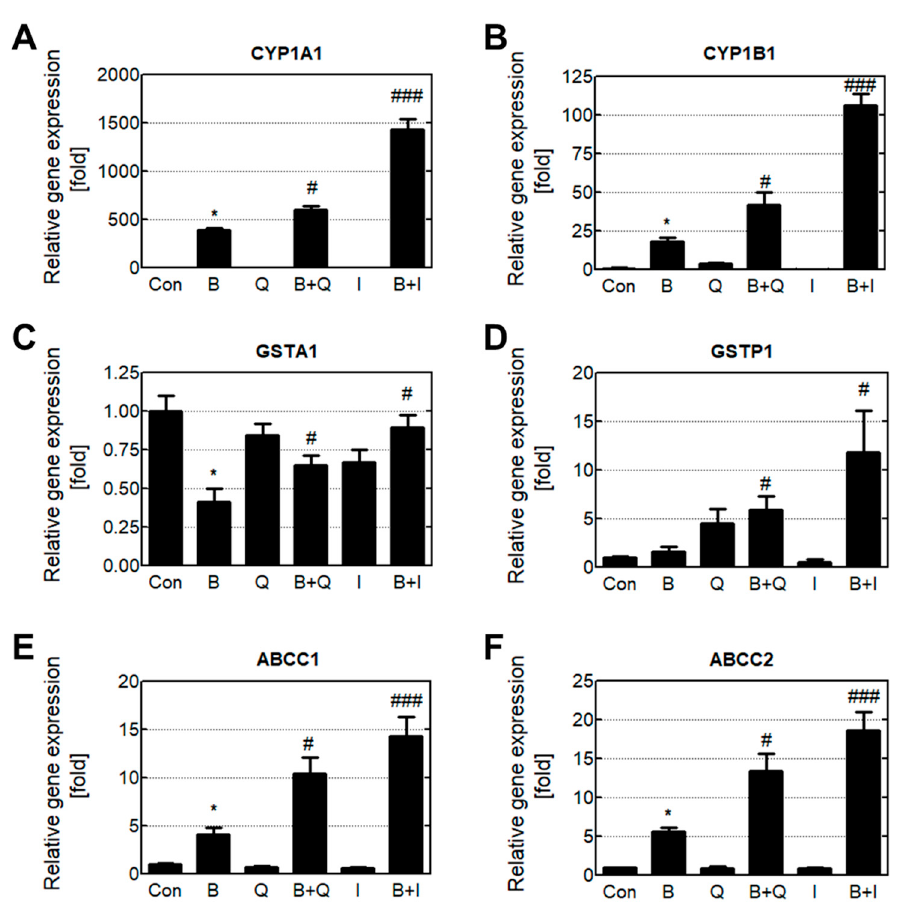
Figure 4. Increased gene expression levels of B[a]P metabolic enzymes induced by quercetin and isorhamnetin. B[a]P was metabolized by phase enzymes. The gene expression levels of the phase I enzymes ( A ) CYP1A1 and ( B ) CYP1B1 , the phase II enzymes ( C ) GSTA1 and ( D ) GSTP1 , and the phase III enzymes ( E ) ABCC2 and ( F ) ABCC3 were analyzed. * p < 0.05 compared with untreated cells; # p < 0.05, ### p < 0.001 compared with B[a]P-treated cells. Con: control; B: benzo[a]pyrene (B[a]P) (10 μ M); Q: quercetin (5 μ M); I: isorhamnetin (5 μ M).